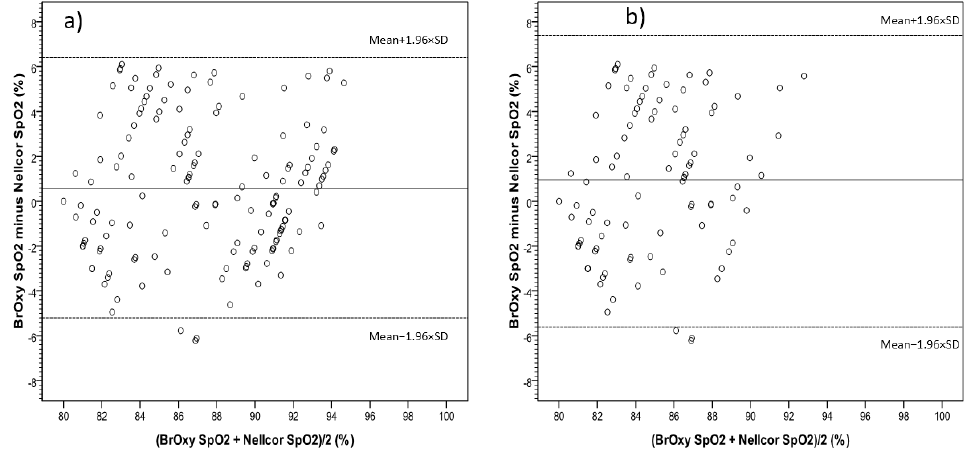
Figure 6. Data pair with Nellcor SpO 2 ≤ 94% ( a ) and ≤ 90% ( b ). Bland-Altman plot, showing the average values of simultaneous SpO 2 as measured with BrOxy M and Nellcor TM in X -axis versus their differences in Y -axis. The mean difference (solid reference line) represents the mean error (bias), and the dashed reference linesare the upper and the lower limits of agreement between BrOxy M and Nellcor TM ( − 5.2 to 6.4% for a ; − 5.5 to 7.4% for b ). In the whole range of Nellcor SpO 2 (from 80% to 100%) (Figure 5), a difference less than − 4% (underestimation of BrOxy M) was observed in seven cases (3.2%): in five cases the standard SpO 2 was ≤ 90%, thus making the underestimation irrelevant from a clinical point of view; the same for the remaining two cases, with Nellcor SpO 2 100% and BrOxy